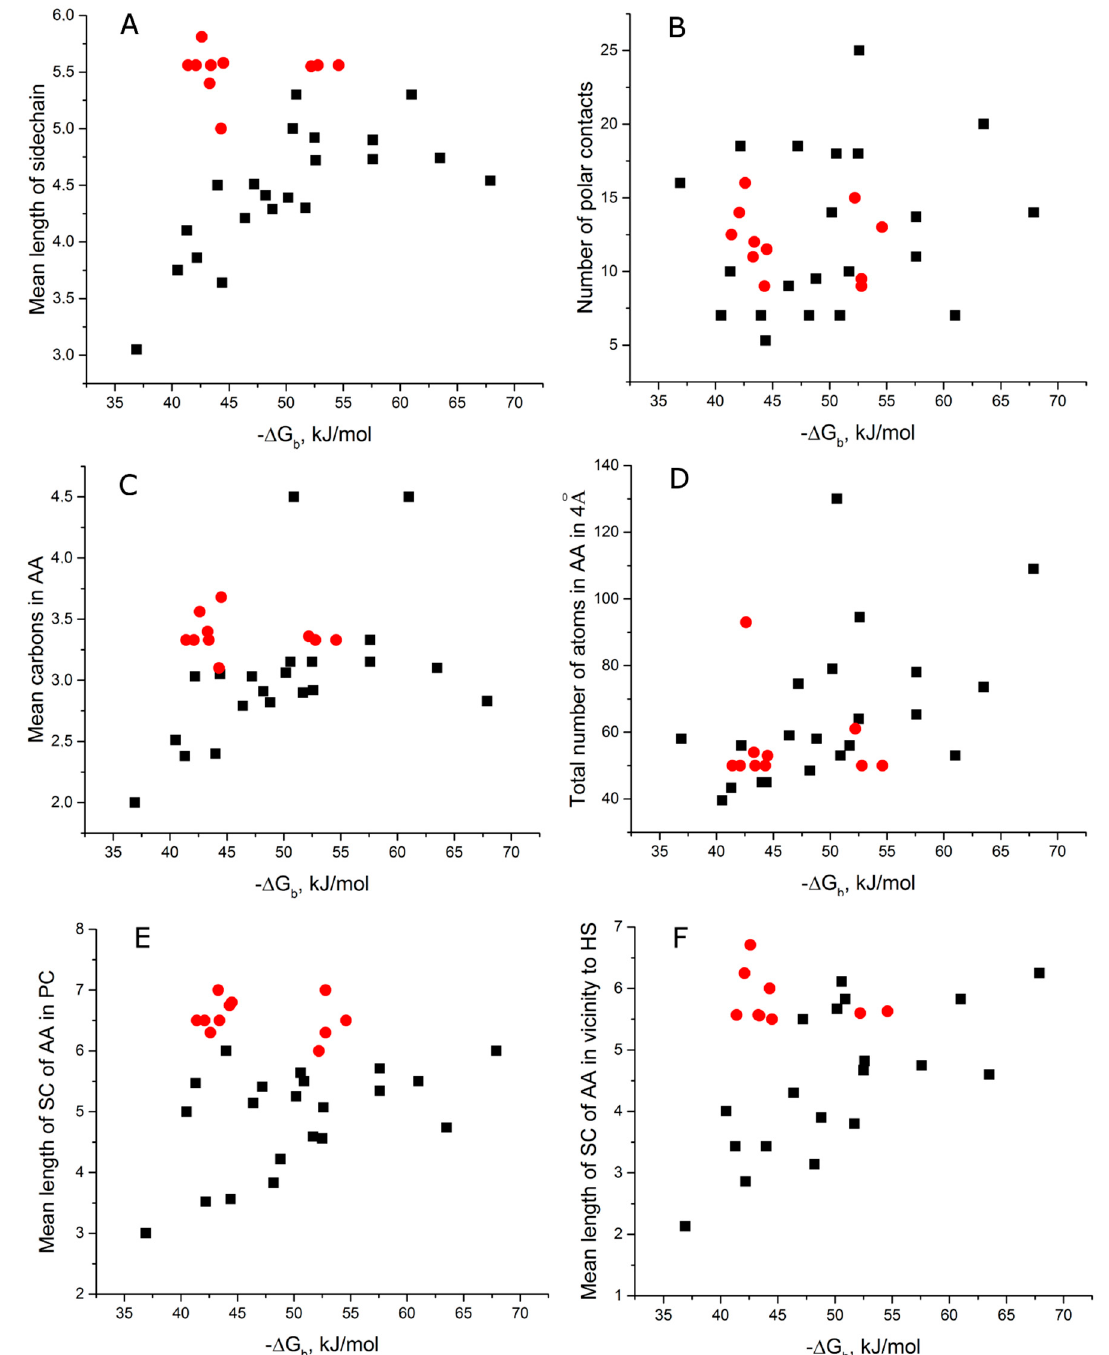
Figure 1. Aptamer–protein complexes. Dependencies of the mean length of the sidechain of amino acids within 4 Å proximity to polar contacts ( A ), number of polar contacts ( B ), mean number of carbon atoms in aromatic or aliphatic groups of the sidechain ( C ), and total number of atoms in amino acids within 4 Å proximity to polar contacts ( D ) versus change in Gibbs free energy during binding. The data are clustered—G-quadruplex aptamers with thrombin are colored in red, and all other aptamer complexes are colored in black.